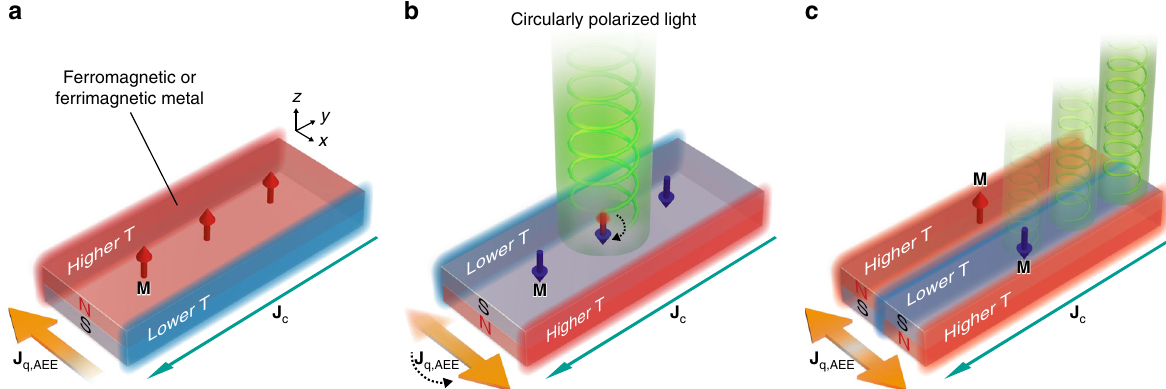
Fig. 1 Concept of magneto-optical painting of heat current. a Schematic of the anomalous Ettingshausen effect (AEE). When a charge current J c passes through a ferromagnetic or ferrimagnetic material with the magnetization vector M , the AEE creates a heat current J q,AEE in the direction of the cross product of J c and M (Eq. (1)). b Light-induced reversal of the AEE-induced heat current. When illuminating the material with circularly polarized light, the M direction is reversed via the all-optical helicity-dependent switching (AO-HDS). Then, the J q,AEE direction is also reversed following the AEE symmetry. c Magneto-optical design of the heat-current distribution. The local J q,AEE direction and resulting temperature modulation distribution can be controlled with magnetic domains pre-designed via the